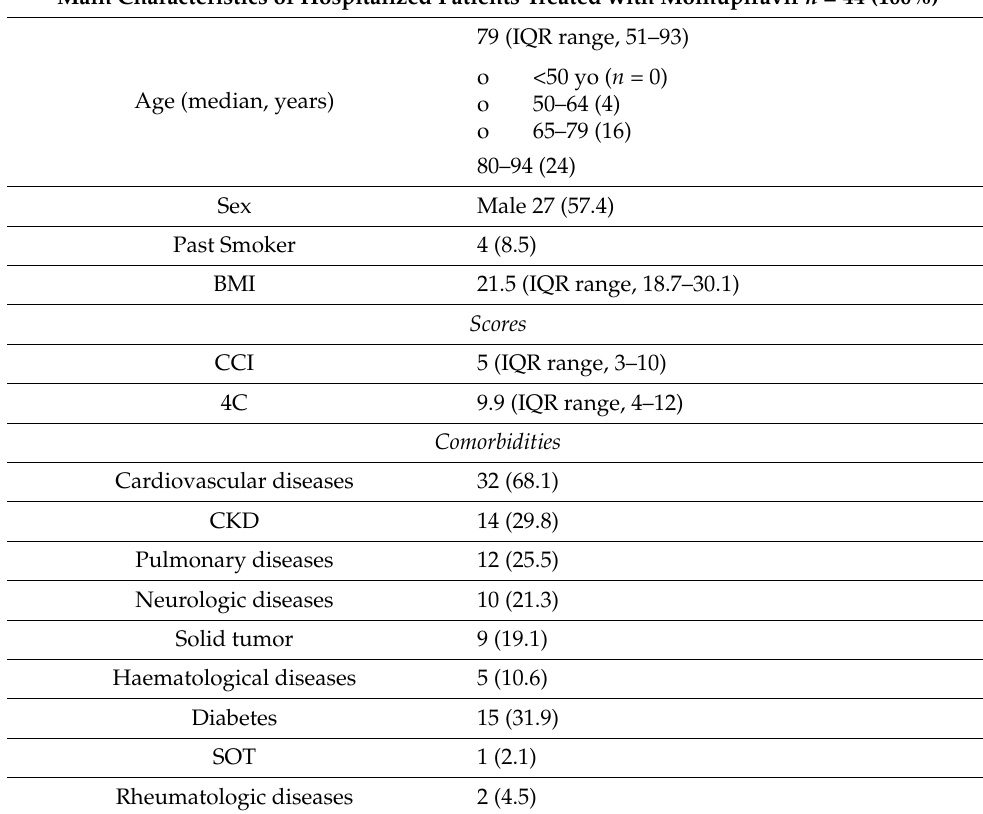
Table 1. Main Characteristics of Hospitalized Patients Treated With